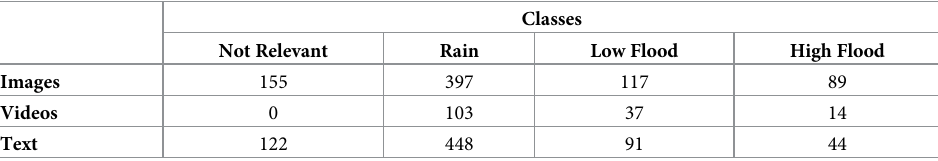
Table 2. Data classified into